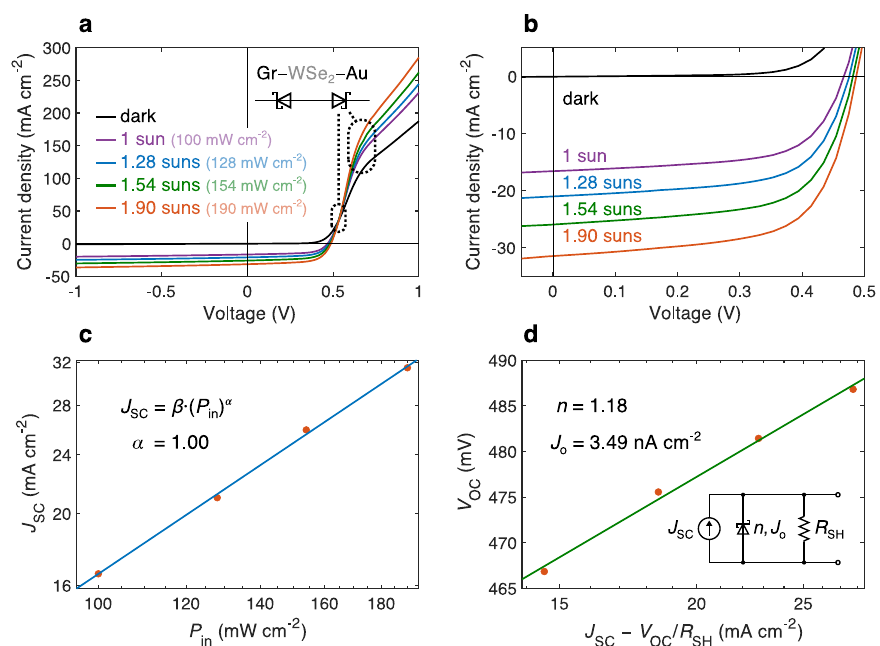
Fig. 2 Electrical characteristics of fl exible WSe 2 solar cells. a Current density vs. voltage ( J – V ) characteristics of WSe 2 solar cells under AM 1.5 G illumination, at various incident power. Inset represents the circuit diagram of Au – WSe 2 and Gr – WSe 2 junctions. With its Fermi level pinned around midgap, Au forms a Schottky junction to WSe 2 opposing the main Gr – WSe 2 Schottky junction, leading to cross-over and roll-over effects occurring around 0.53 and 0.65 V, respectively 57,58 , as marked by dotted ovals. b Zoomed-in view of the photovoltaic region of the J – V measurements shown in a . c Short- circuit current density ( J SC ) of the devices. P in , incident power; symbols, measurements; line, power law fi t. d Open-circuit voltage ( V OC ) of the devices. Note logarithmic axes in c and horizontal axis in d . R SH , shunt resistance; symbols, measurements; line, fi t. Inset shows a representative circuit diagram. n is the ideality factor and J o the dark saturation current density from the diode fi